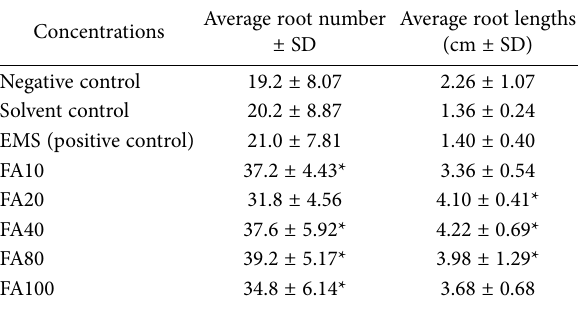
Table 1. The average root numbers and root lengths in control and treatment groups after 24h treatment (Analysis were carried by One Way